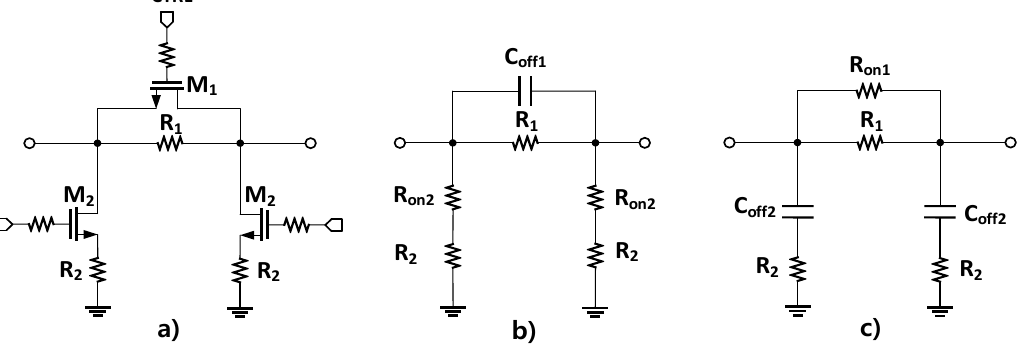
Figure 10. A schematic of the Pi-type resistive attenuator cell ( a ) and simplified models of it in the OFF ( b ) and ON ( c ) states. Table 4. The device parameters used in the attenuator design.